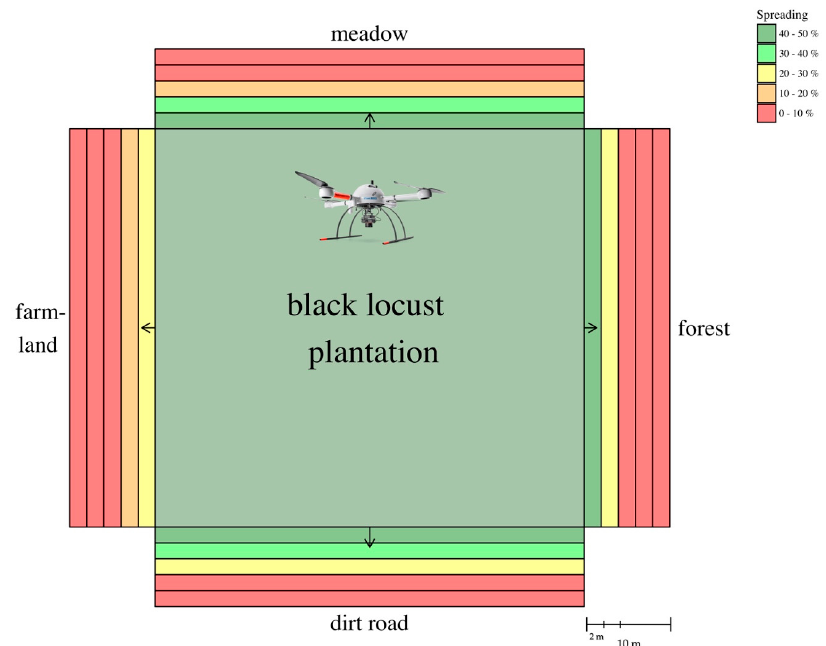
Figure 6. Spreading: outline average values of the areas; 0–2 m, 2–4 m, 4–6 m, 6–8 m, 8–10 m depending on the surrounding areas: meadow, farmland, dirt road, and pine forest. The spreading depends on the proportion of black locust; dark green stands for 40%–50%, light green indicates 30%–40%, yellow is 20%–30%, orange 10%–20% and red 0%–10%. The arrows show the average spreading distance of black locust. For an overview of the results, see Table 4. Database = 2124 m [82].